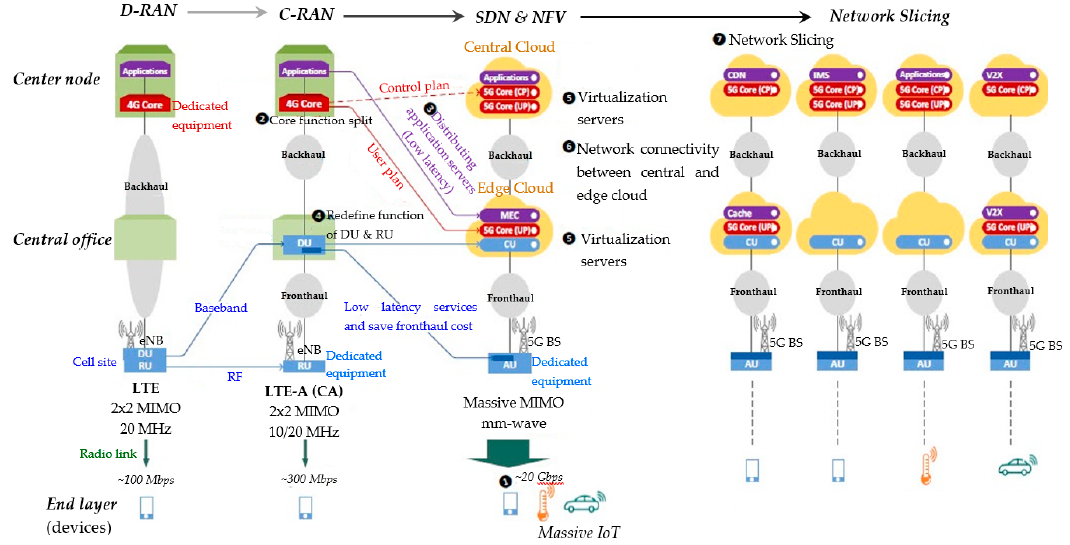
Figure 5. Major milestones of the evolution of cellular networks topology to achieve end-to-end low latency.